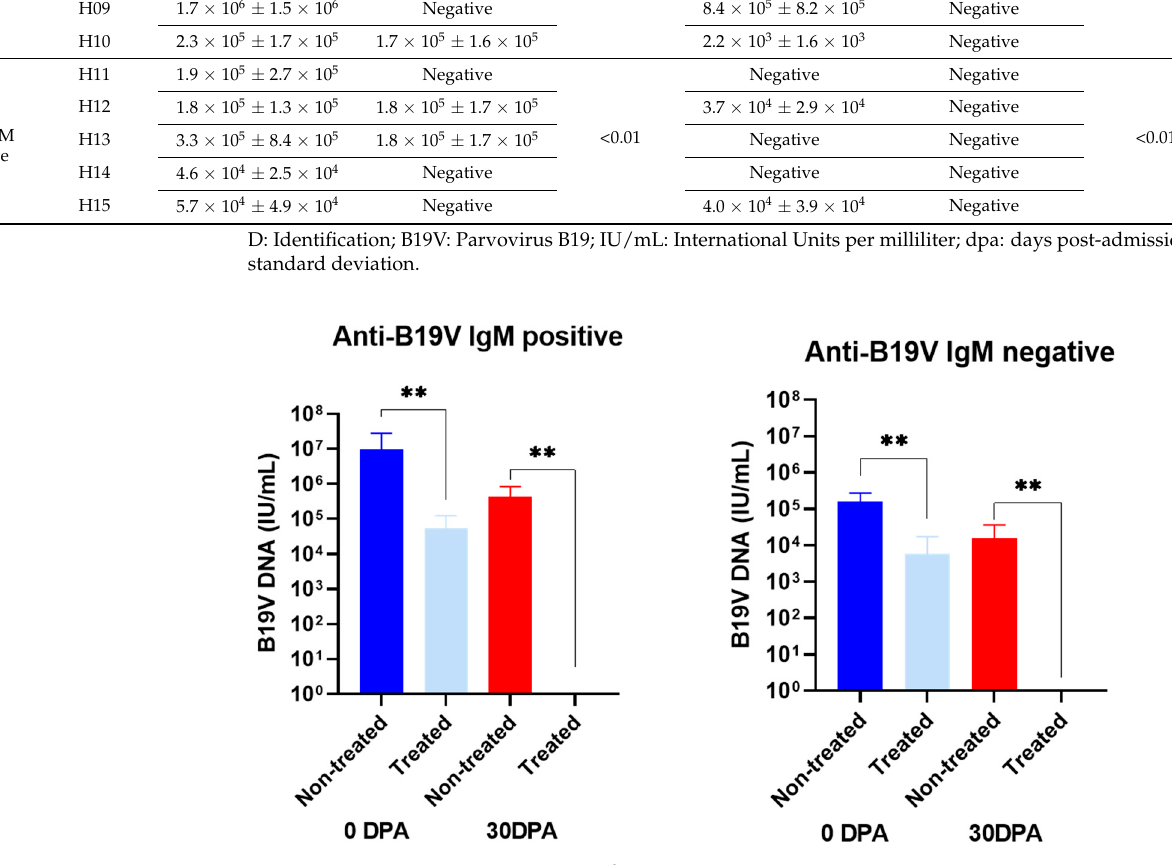
Figure 3. Performance of Benzonase ® pretreatment in serial serum samples collected from patients with anti-B19V IgM positive and negative. IU/mL: International Units per milliliter; DPA: Days post-admission; ** p -value < 0.01